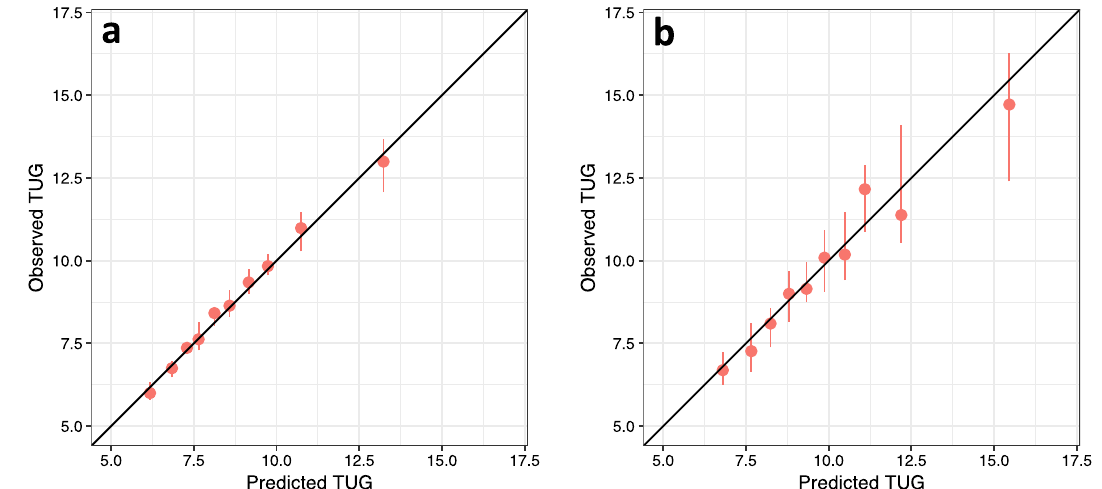
Figure 4. Calibration plots for neighbors-based predictions in: ( a ) training and ( b ) test datasets. Training and test datasets were divided into deciles according to the predicted TUG times. For each decile, the median observed TUG time is plotted against the median predicted TUG time. Error bars indicate the standard error of the